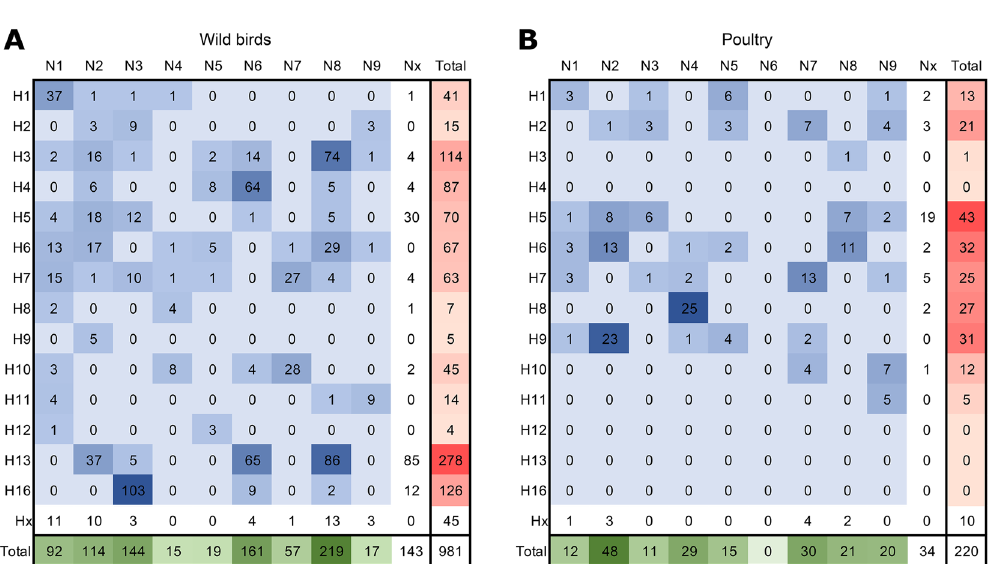
Figure 2. Virus subtypes and subtype combinations detected in wild birds and poultry. Number of hemagglutinin (HA) subtypes, neuraminidase (NA) subtypes, and HA/NA subtype combinations of low pathogenic avian influenza (LPAI) viruses detected in ( A ) wild birds and ( B ) poultry, as part of virological and serological surveillance for avian influenza (AI) virus infections in the Netherlands, January 2006-September 2016. HA subtypes (red), NA subtypes (green), HA/NA subtype combinations (blue) were coloured according to the frequencies of